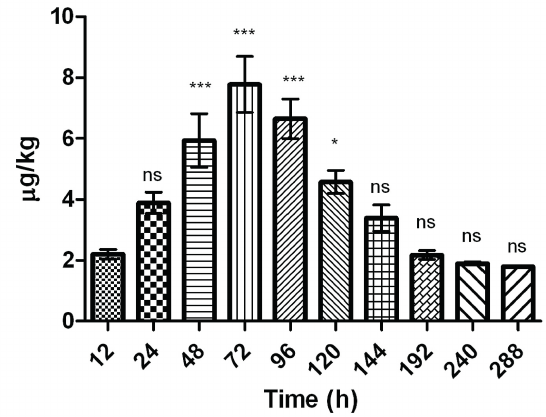
Figure 6: Marker residue concentration of eprinomectin B and kidney of cattle treated with pour-on product dose of 1 mL per 10 kg of body weight (500 μg eprinomectin kg -1 Bw) (P ˂ 0.001).